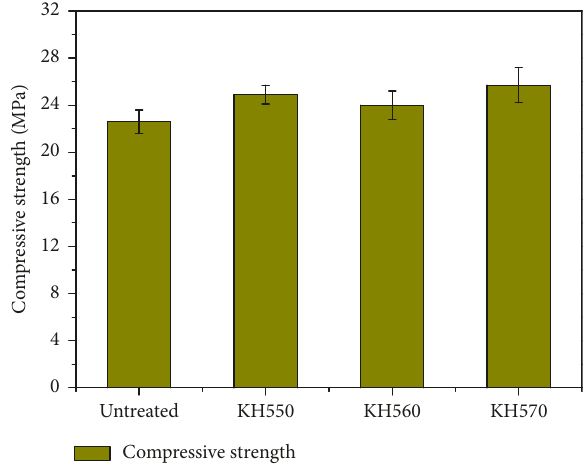
Figure 3: Compressive strength of TPR cement slurry modified by different silane coupling